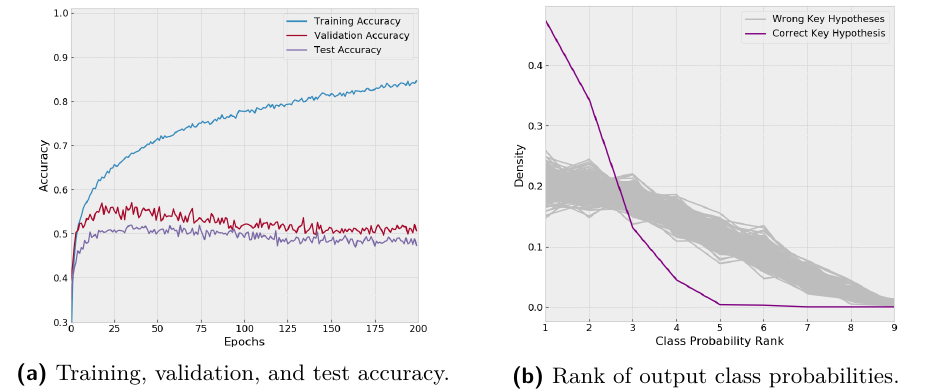
Figure 1: Machine learning metrics and class probability ranks for the Piñata SW AES